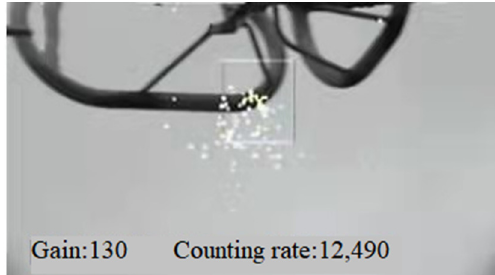
Figure 5. The coronal discharge condition of a tension insulator string grading ring and shielding ring at the outgoing side of phases A, B and C of the main transformer.